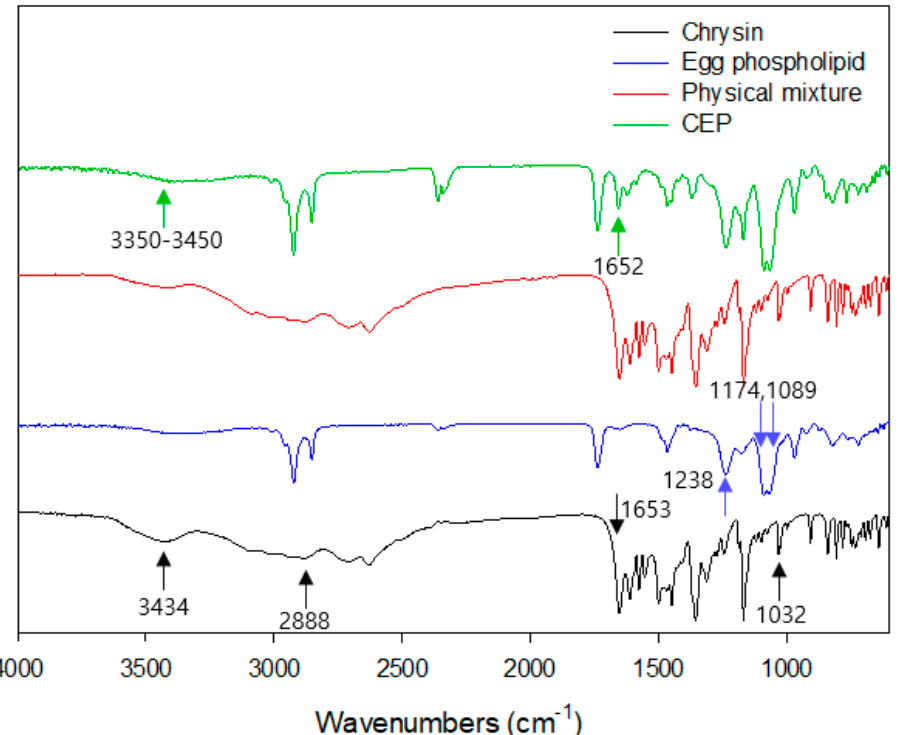
Figure 3. Fourier-transform infra-red spectra of chrysin, egg phospholipid, physical mixture, and CEP- 1:3.